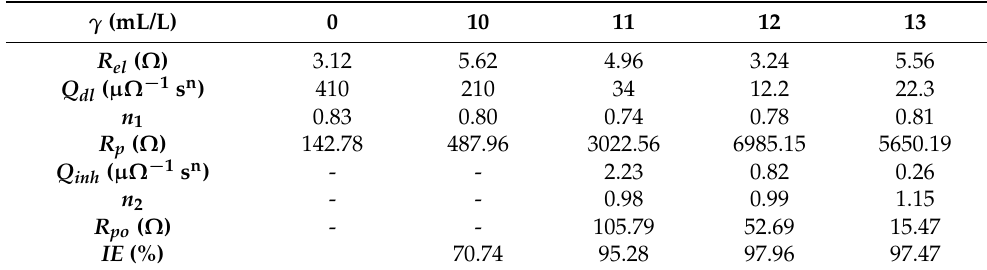
Table 5. Electrochemical parameters determined from Nyquist and Bode plots scanned on the carbon- steel sample in the simulated brine saturated with CO 2 with and without the inhibitor in static conditions (Adapted from [24]).